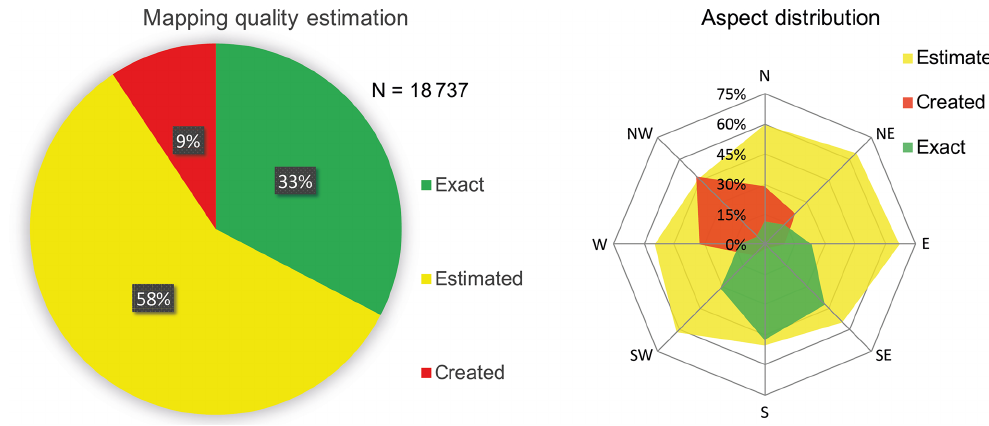
Figure 4. Mapping quality estimation and its aspect based on the classes described in Table 2.